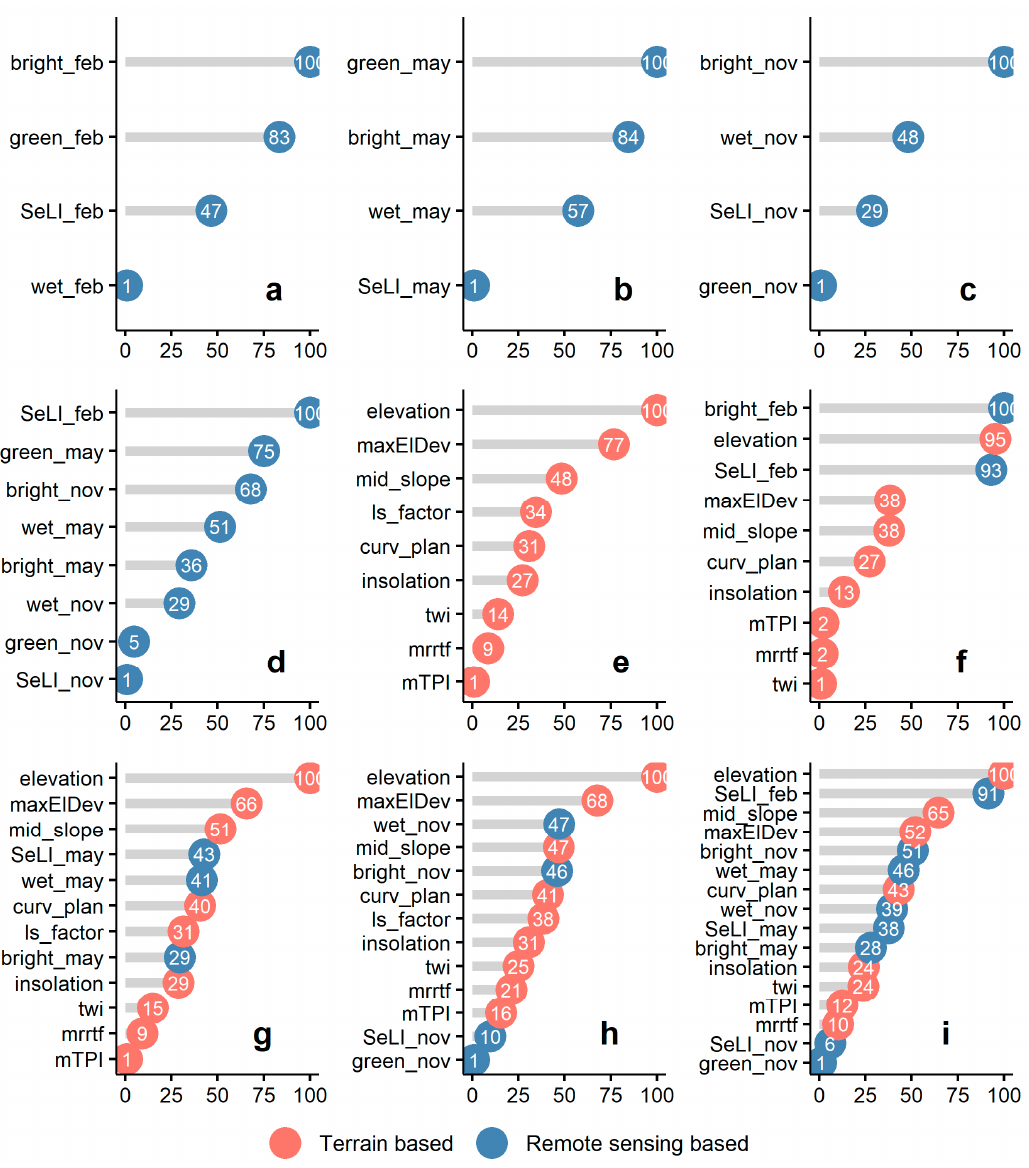
Figure 7. Variable importance for different prediction models. ( a ) Sentinel-2 (February), ( b ) Sentinel-2 (May), ( c ) Sentinel-2 (November), ( d ) Sentinel-2 (February, May, November), ( e ) Terrain only, ( f ) Terrain + Sentinel-2 (February), ( g ) Terrain + Sentinel-2 (May), ( h ) Terrain + Sentinel-2 (November), ( i ) All (Terrain + Sentinel-2 (February, May, November)).